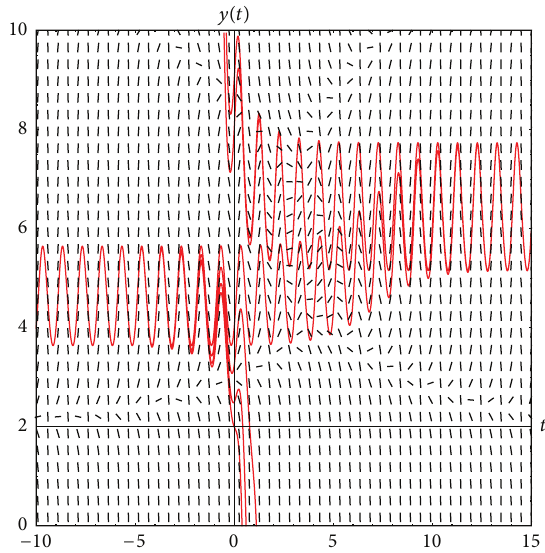
Figure 9: Pinched together pieces of upper (blue) and lower (purple)nullclinesandoneofsolutionsto(49)escapingthetrapping region for 𝜎 = 3.8 .